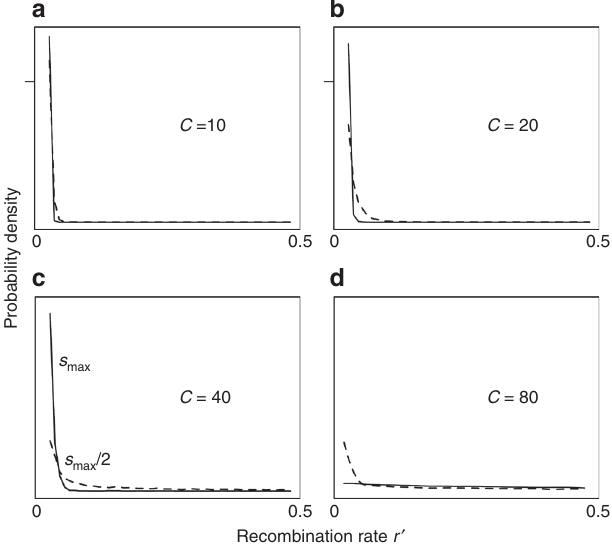
Fig. 4 Stationary distribution of the recombination rates between two co- modulated target loci. We assume that the initial target locus starts at the optimal distance to the plasticity modi fi er loci and a new target locus is introduced downstream away from the plasticity modi fi er-target haplotype. N = 25,000 and C = 10 with s = 0.5 ( a ), C = 20 with s = 0.25 ( b ), C = max max 40 and 80 with s max = 0.15 ( c , d ) for each of the target loci (broken line indicates s max /2), with N µ = 0.1. One thousand replicate simulations were run for a 100 N burn-in generations (where the distribution stabilized) and the stationary distribution was recorded over the next 100 N generations (to a 2 decimal place precision). The tick marks y axes in top panels indicate height of y axes in bottom